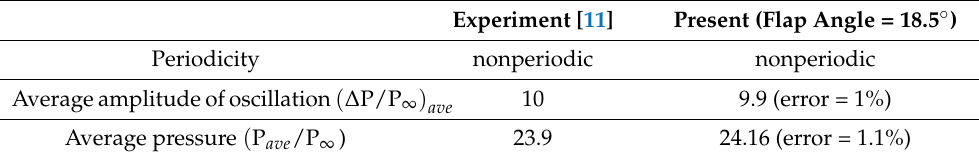
Table 2. Comparison of pressure oscillation characteristics at x/h = 12.21 with experimental data. Experiment [11]